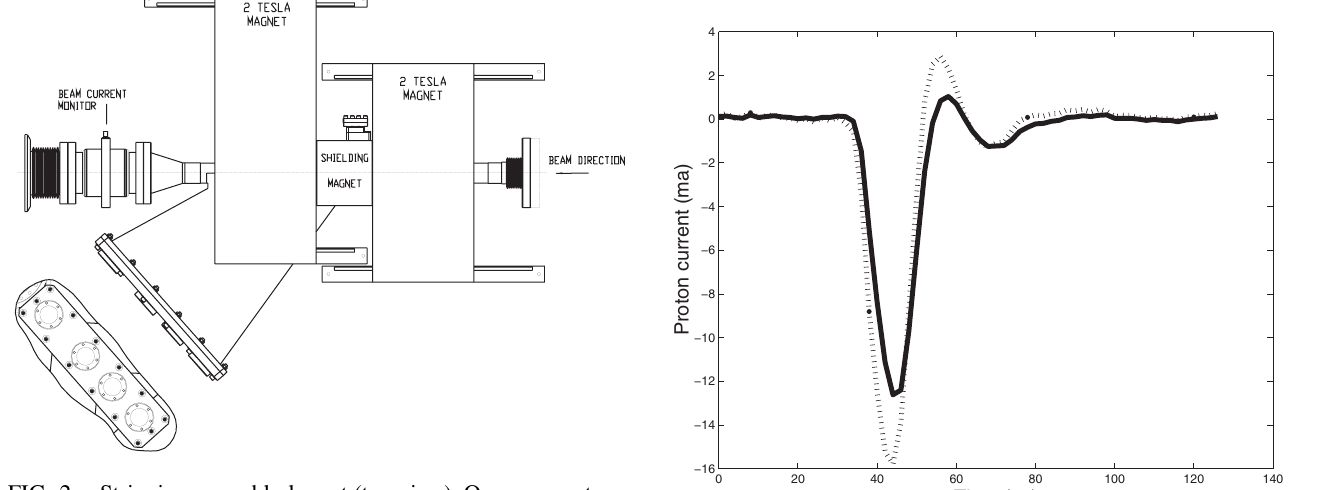
FIG. 2. Stripping assembly layout (top view). One can see two